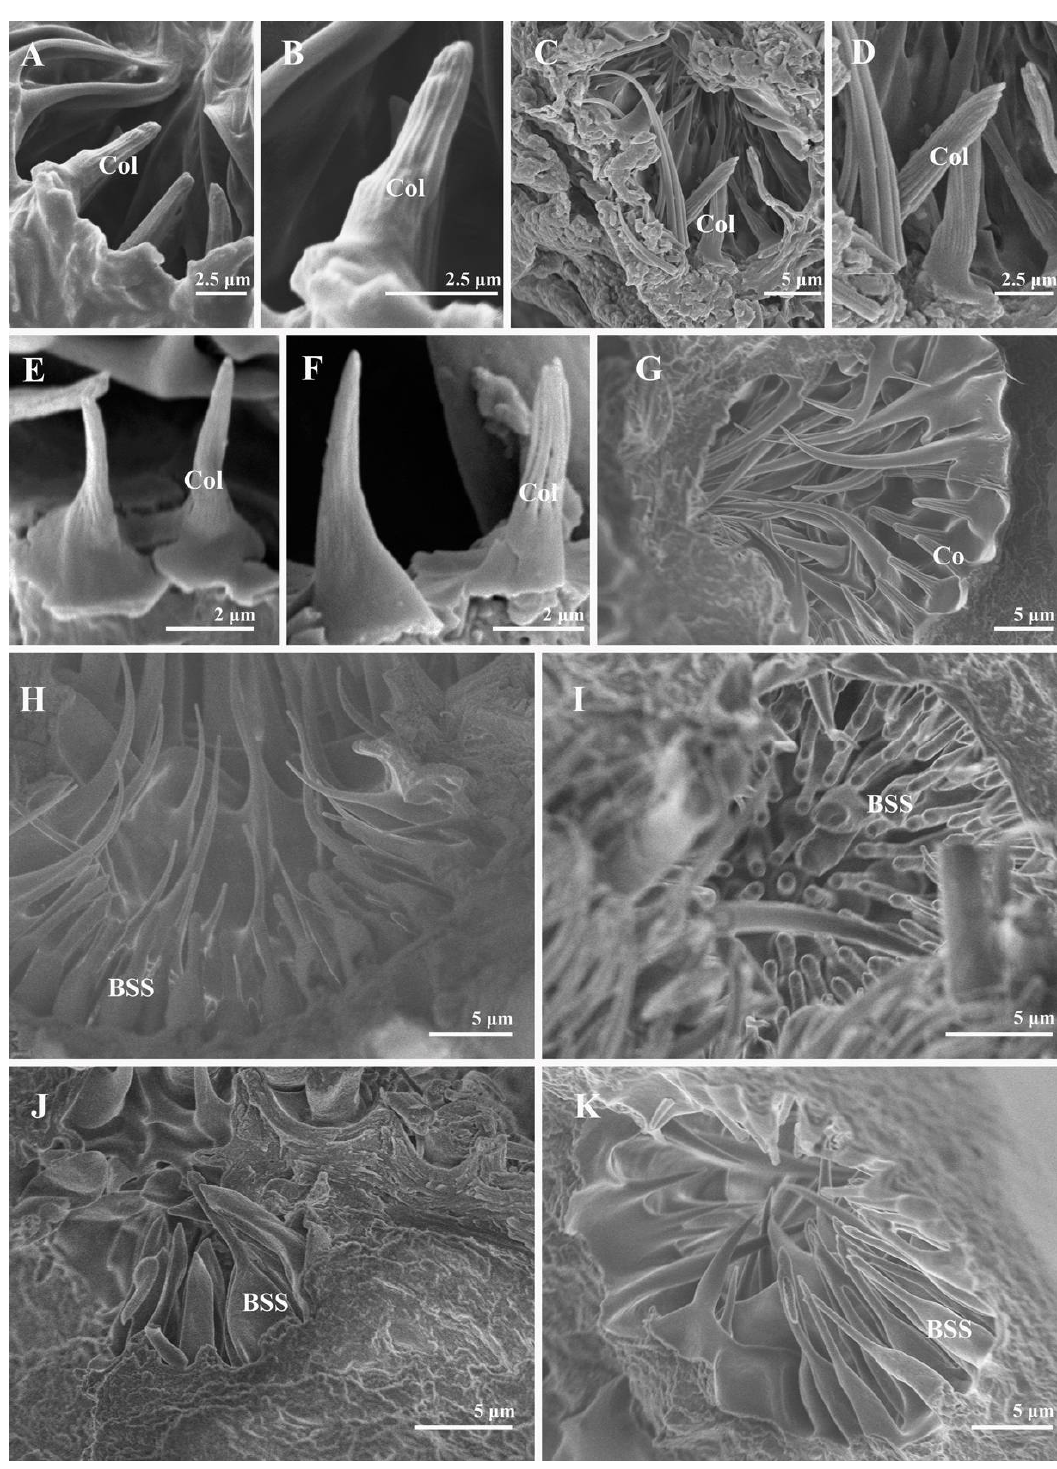
Figure 8. The sensilla in the sensory pits of male and female in sarcophagid species. ( A , B ) male of S . albiceps ; ( C , D ) male of S . peregrina ; ( E , F ) male of W . magnifica ; ( G ) female of W . bella ; ( H , I ) female